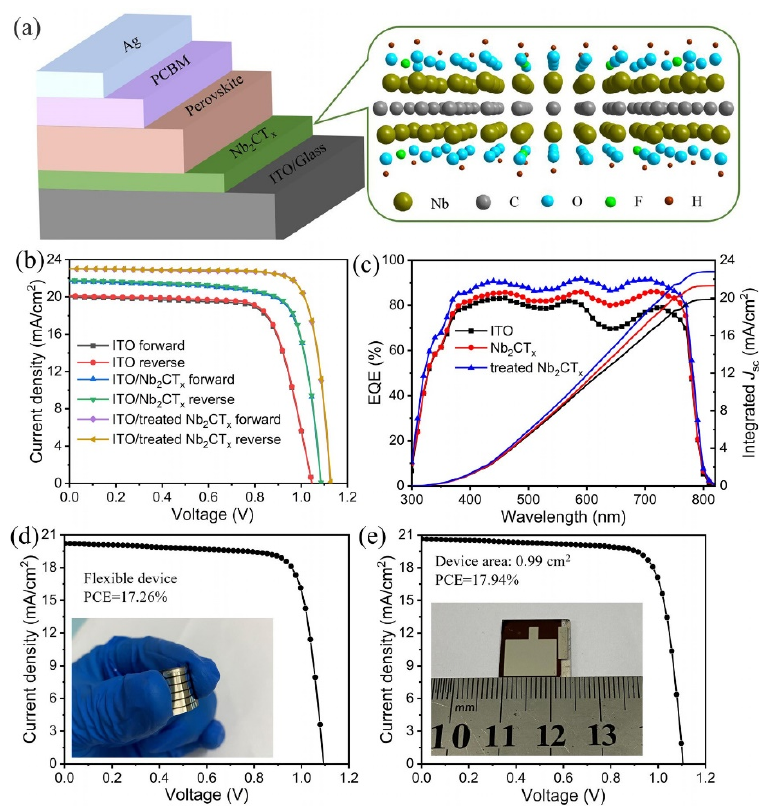
Figure 10. ( a ) The schematic diagram of the device structure and the structure of Nb 2 CT x MXene. ( b ) JV curves of PVSCs measured under different scan directions. ( c ) External quantum efficiency (EQE) and integrated Jsc curves of various PVSCs. JV curves of the flexible ( d ) and large-area ( e ) PVSCs using Nb 2 CT x -HTL treated with oxygen plasma. Reprinted with permission from ref. [124]. Copyright 2021 AIP Publishing LLC.